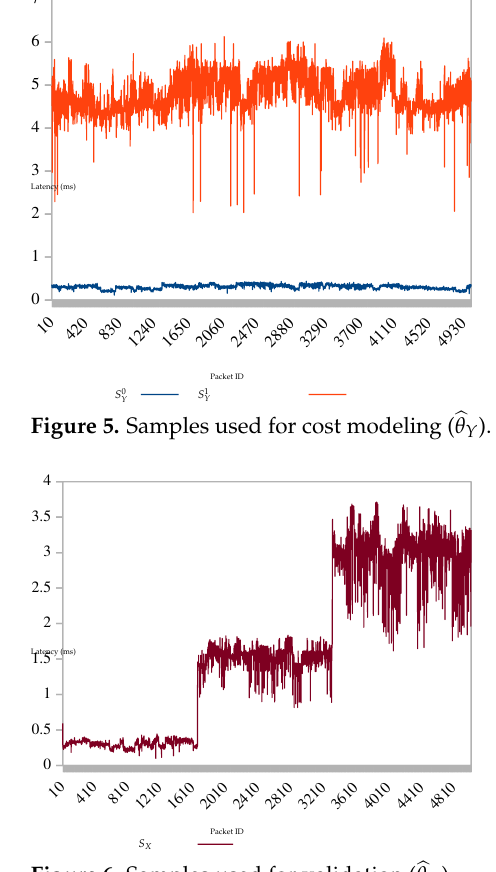
Figure 6. Samples used for validation ( (cid:98) θ X